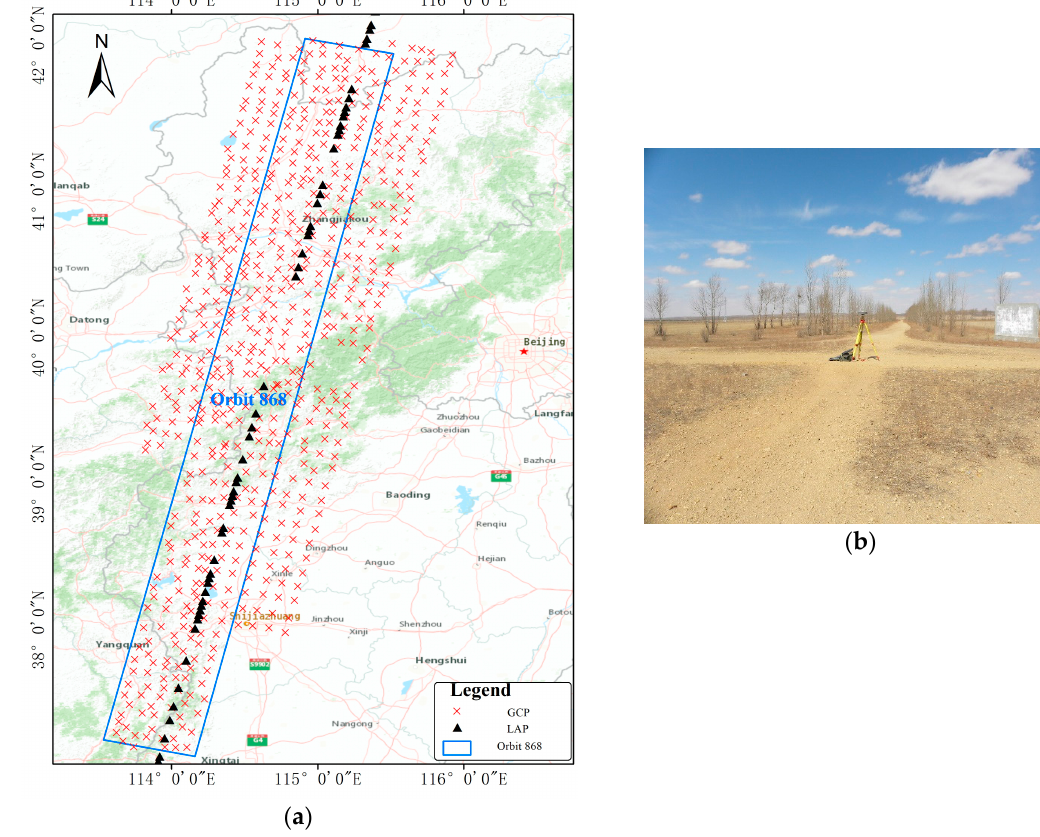
Figure 5. Experimental data and reference data at the Taihang research area. ( a ) Spatial coverage of the research area; ( b ) image showing a GCP (Ground Control Point) measured primarily by using a static Global Positioning (GPS) receiver. Table 2. General information for the experimental data.